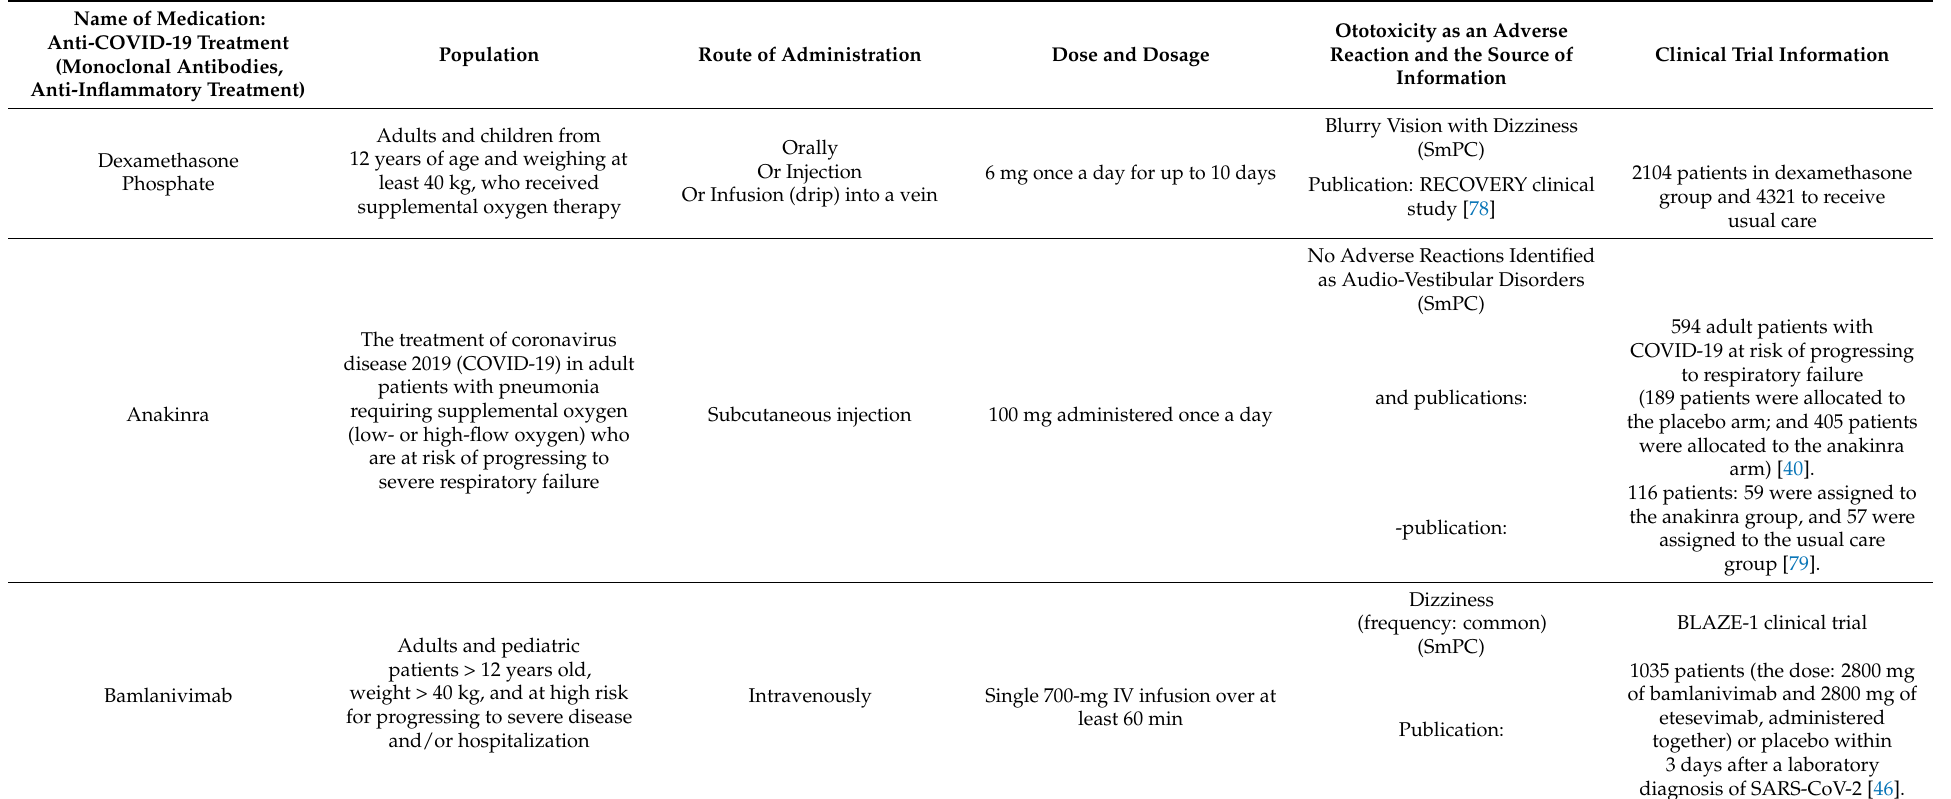
Table 1. Summary of potential ototoxicity and audio-vestibular disorders as an adverse reaction to the prevention and treatment of COVID-19 (based on